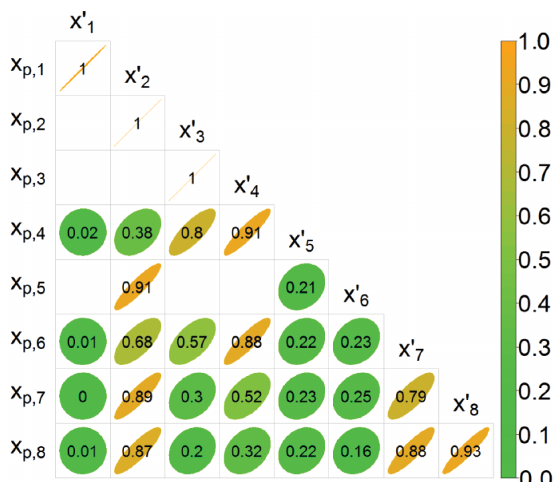
Figure 7. The C storage potential of individual pools ( x p ,i ) as in- fluenced by net C pool change of different pools ( x (cid:48) responding rows. The correlation coefficients show the degree of influence of net C pool change in one pool on the C storage po- tential of the corresponding pool through the network of C transfer. The empty cells indicate no pathways of C transfer between those pools as indicated in Fig.